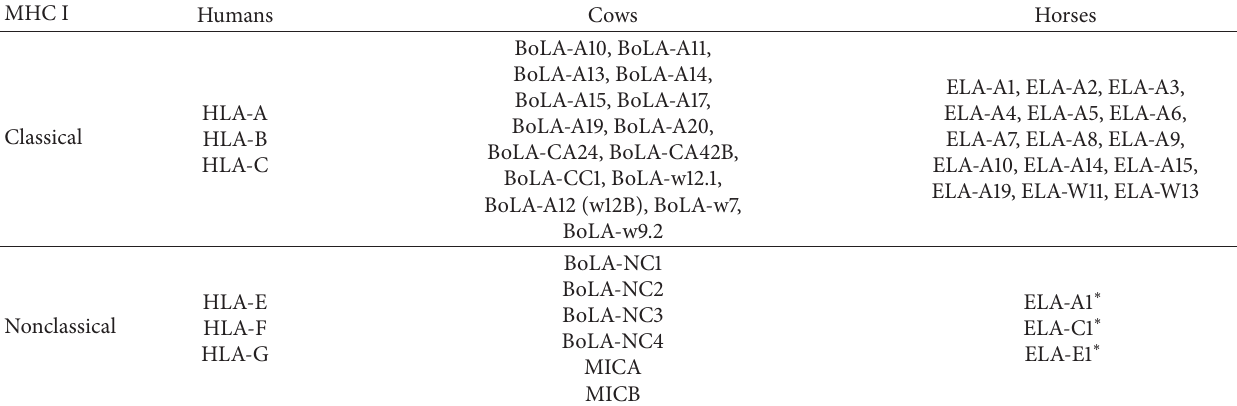
Table 1: Classes of MHC I expressed in humans, cows, and horses [6, 25–28]. Cows